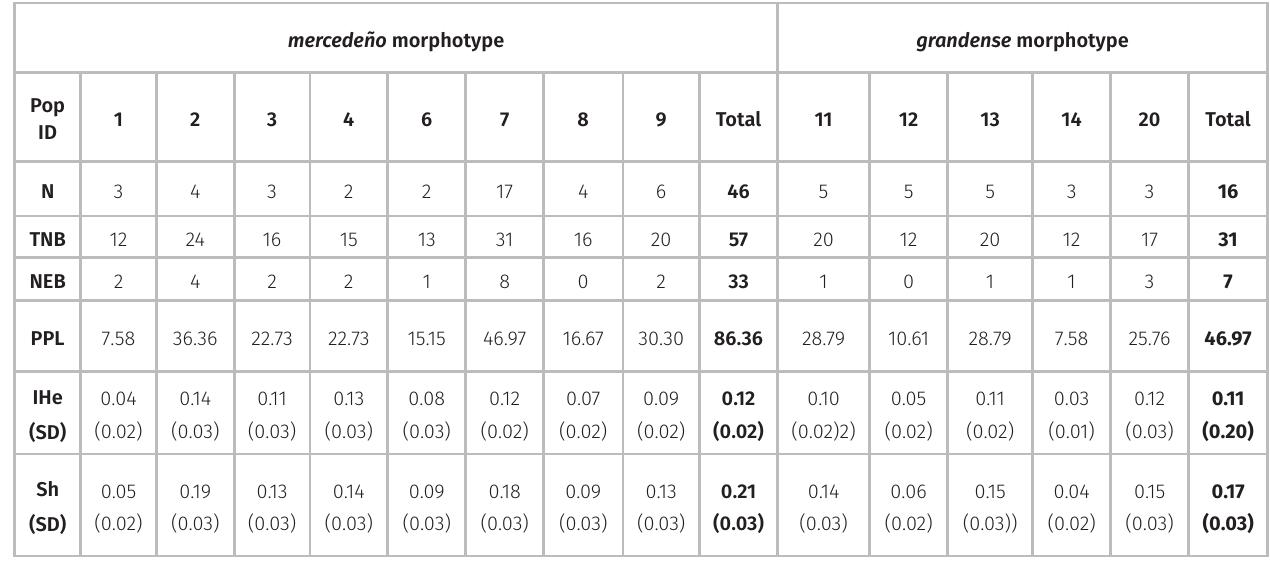
Table III. Summary statistics of genetic diversity base on 66 RAPD loci for the 13 populations of Turnera sidoides subsp. carnea analyzed. N = simple size; TNB= total number of bands; NEB= number of exclusive bands; PPL= percentage of polymorphic loci; IHe= impartial expected heterozygocity with Lynch & Milligan correction factor; Sh= Shannon´s index; SD= standard